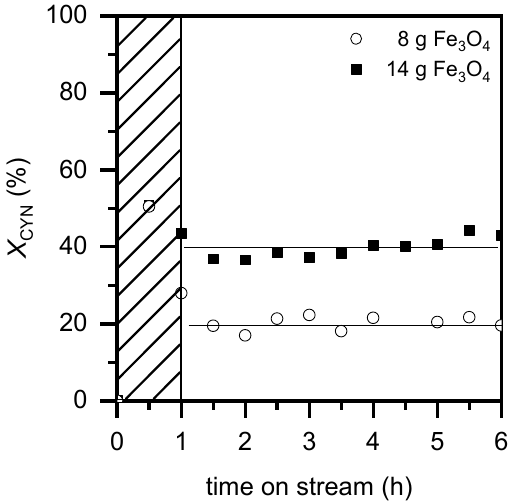
Figure 1. Effect of the catalytic bed load on the removal of cylindrospermopsin (CYN) upon catalytic wet peroxide oxidation (CWPO) (flow rate = 0.2 mL min − 1 , [CYN] 0 = 25 μ g L − 1 , [H 2 O 2 ] 0 = 2 mg L − 1 , pH 0 = 5, T = 25 °C).